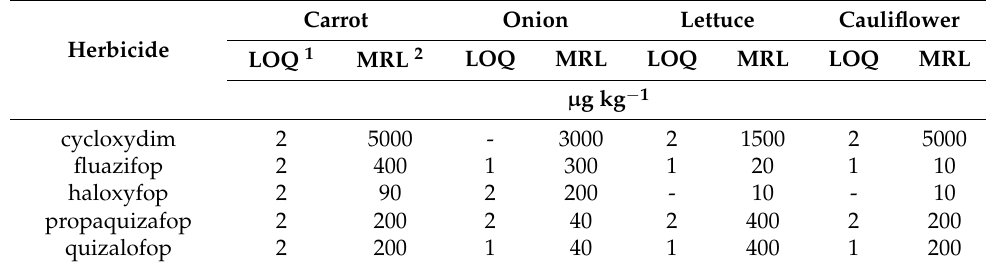
Table 5. Limits of quantification and maximum residue limit for tested herbicides and